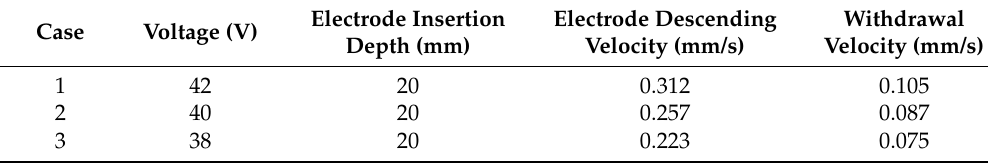
Table 3. Electrode drop velocity with different process